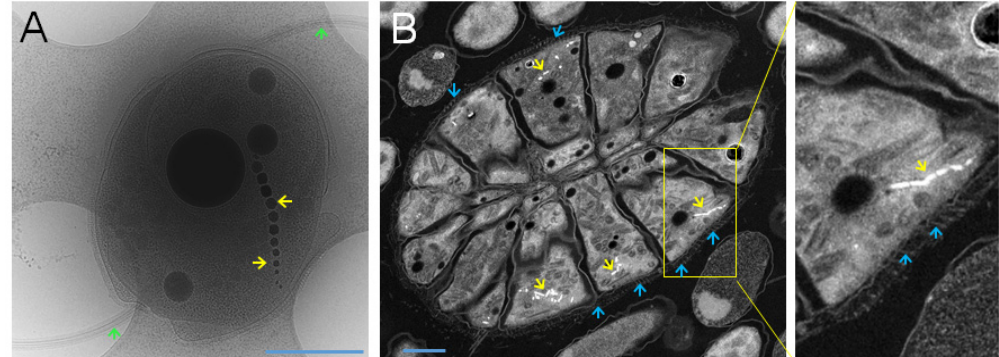
Figure 1. Magnetosomes and flagella of magnetotactic bacteria. ( A ) Bilophotrichously flagellated MO-1 cells possess two sheathed flagellar bundles (green arrow) and one magnetosome chain (yellow arrow). ( B ) Peritrichously flagellated ellipsoidal magnetoglobule with flagella (blue arrows) and magnetosomes (yellow arrows). Only the portion of flagellar filaments in the surface matrix was preserved during sample preparation. Scale bar is equal to 0.5 µ m. Courtesy of the electron cryotomography micrograph ( A ) from Dr. J. Ruan and Professor K. Namba, and of the Scan-TEM high-angle annular dark-field (STEM-HAADF) mode micrograph ( B ) of ultrathin sections of high-pressure freezing / freeze substitution fixation (HPF / FS) fixed ellipsoidal magnetoglobule from Professor N. Menguy and Dr. A. Kosta.